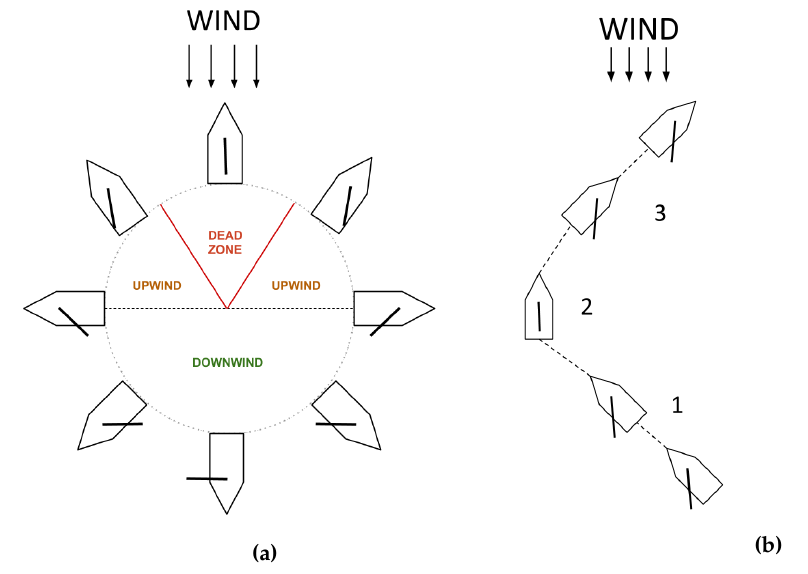
Figure 2. Sailing maneuvers on ( a ). Example of a sailing tack on ( b